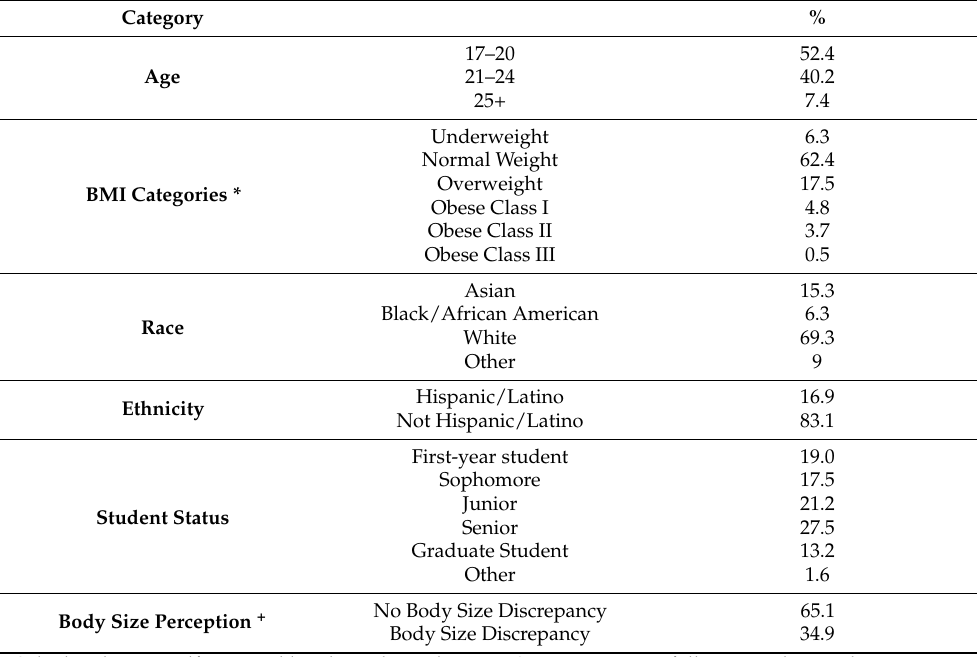
Table 3. Characteristics of 189 Young Adult Women.